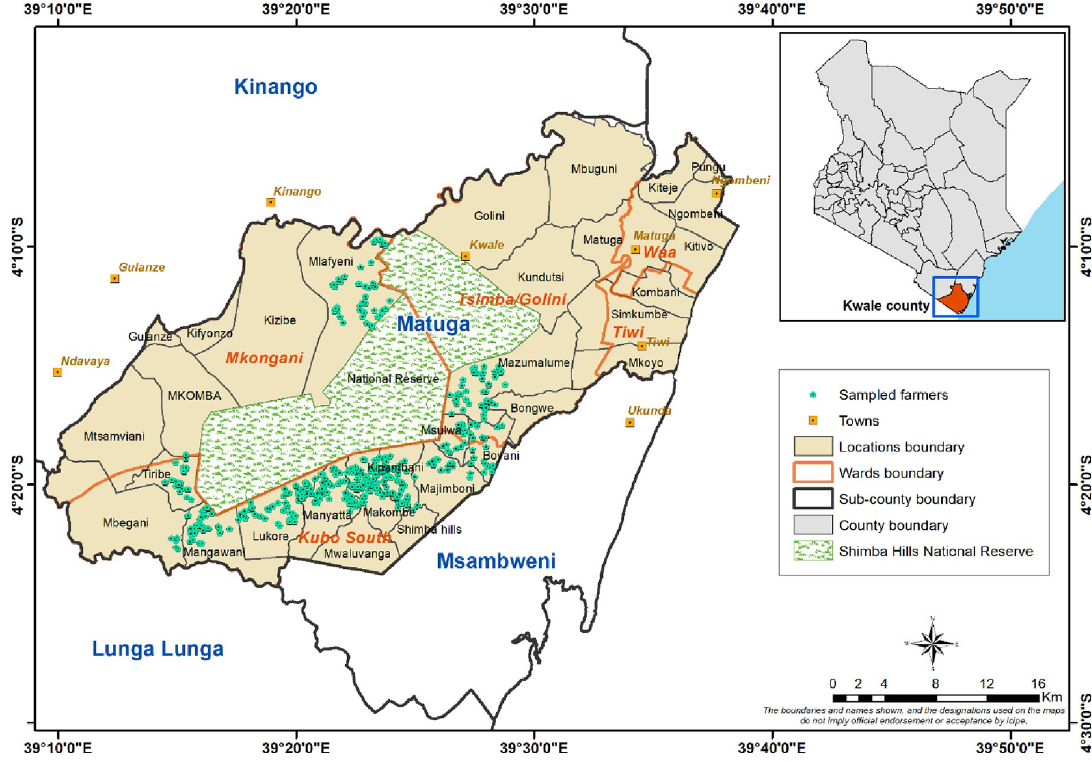
Fig 1. Cartography: Emily Kimathi, GIS unit, icipe; The map was developed using the QGIS 3.16 software, https://qgis.org/en/site/ forusers/download.html.